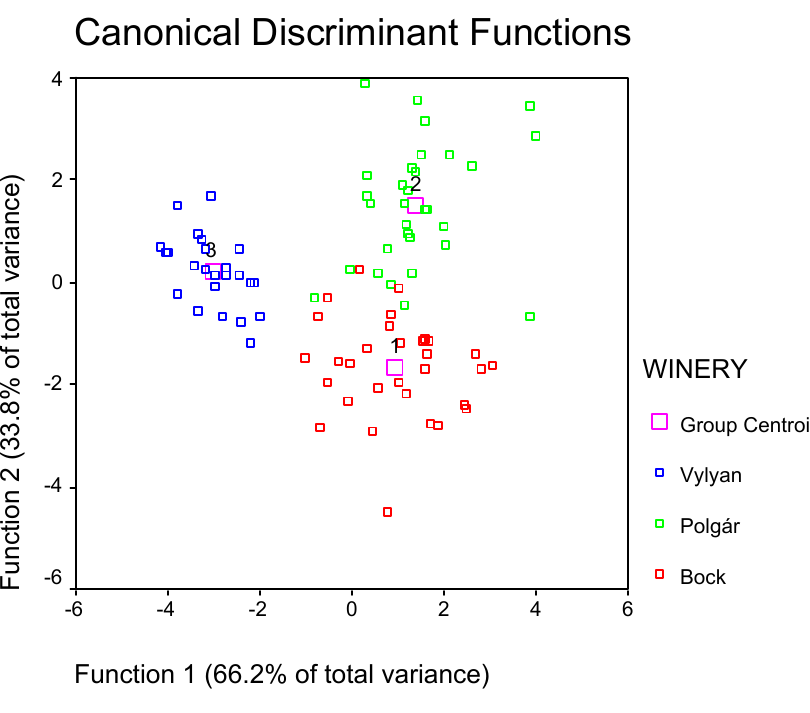
Figure 2. Canonical discriminant analysis of Hungarian red wines (n=92) from the “Villány” region based on their polyphenol content.